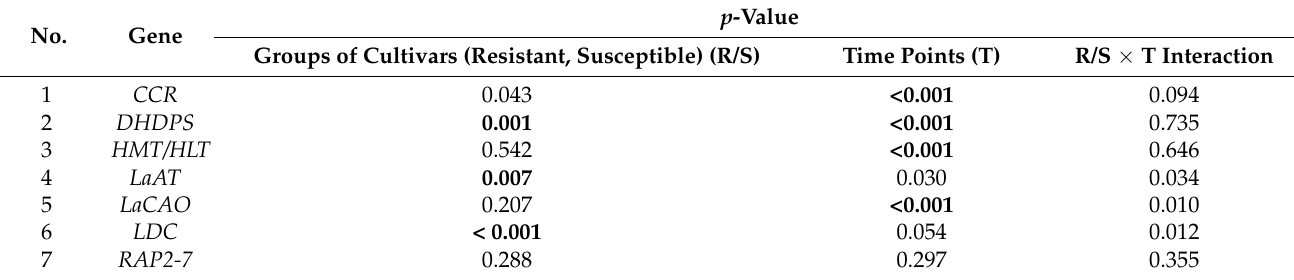
Table 6. Summary of ANOVA for two groups of narrow-leafed lupin cultivars with different infection resistance levels: plants mildly affected by the disease are referred to as ‘resistant’ (four cultivars), while plants severely affected by the disease are referred to as ‘susceptible’ (four cultivars). Expression was analyzed by qPCR assay. Effects were considered significant for p < 0.01 (marked in bold). Full names of genes are listed in Table